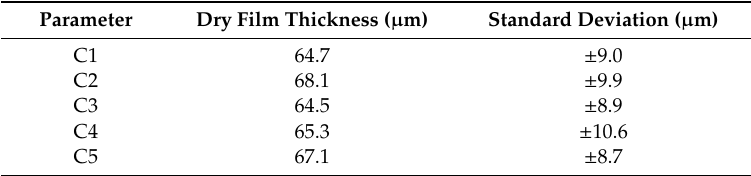
Table 2. Dry film thickness of the different coating sample. The value presented is the average of 10 measurements.